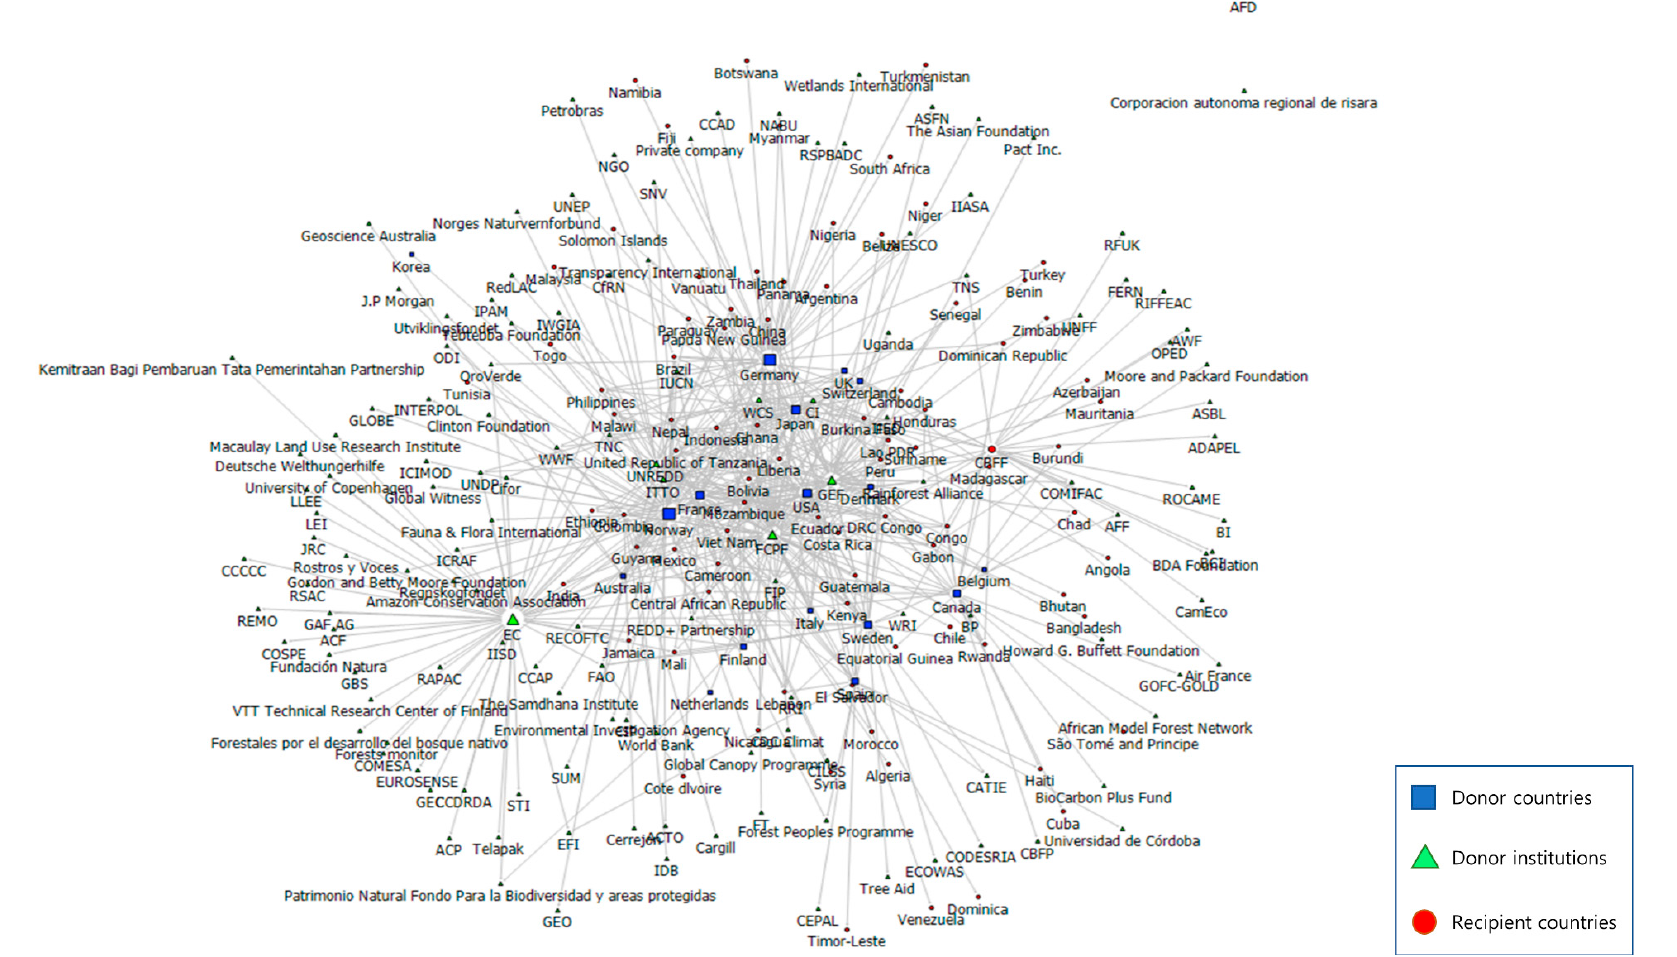
Figure 5. Out-degree centrality in global REDD+ financial network in 2011.